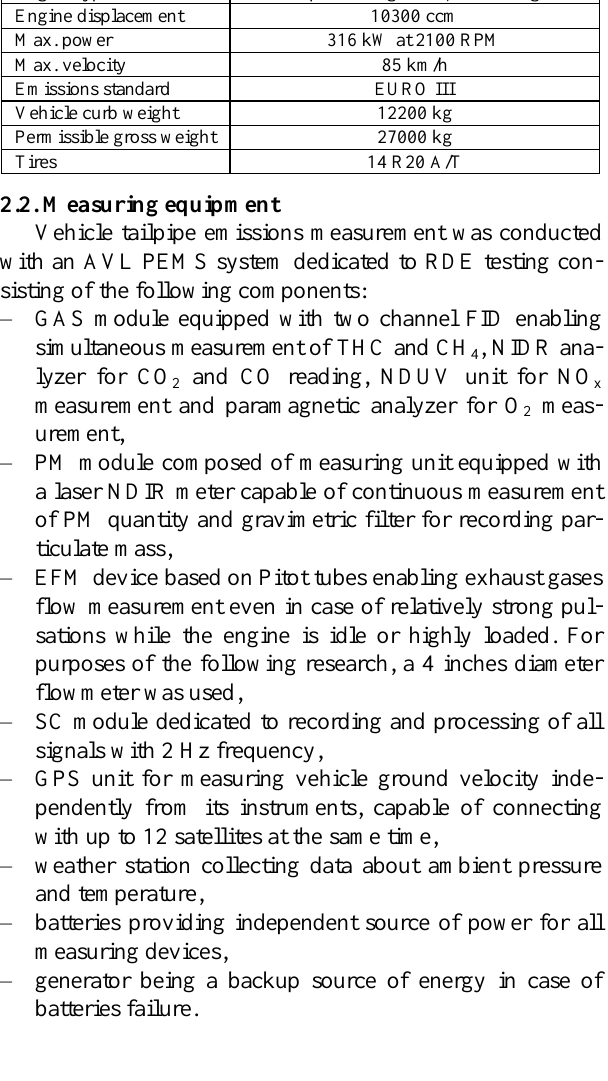
Table 1. Selected parameters of the test vehicle Category N3G Mileage 321 km Engine